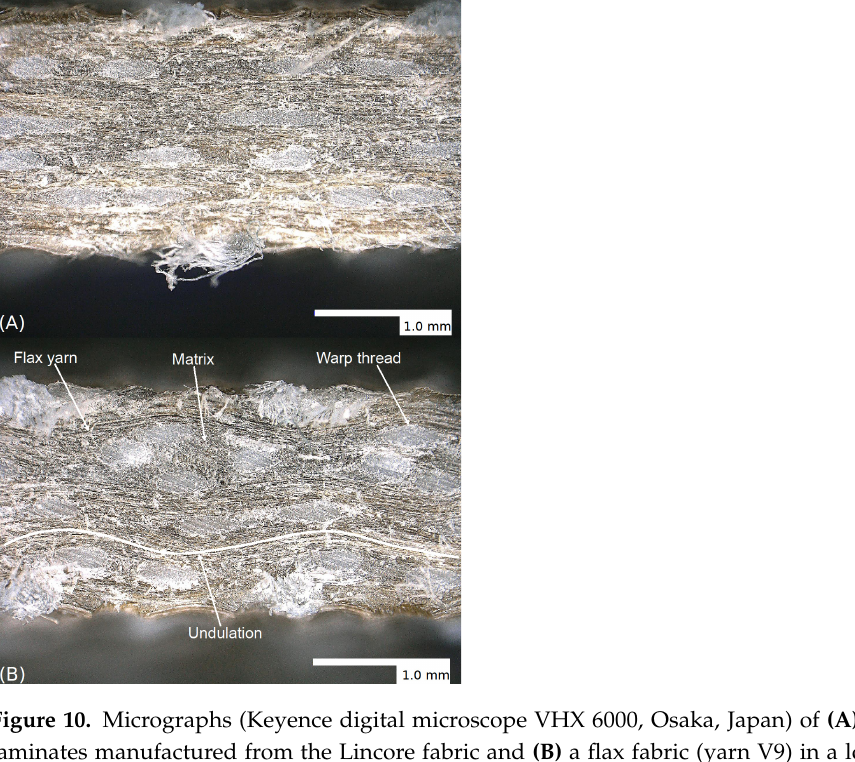
Figure 9. Tensile strength ( A ) and Young’s modulus ( B ) of composites produced by vacuum infu- sion and autoclave injection. The results are shown as mean values with the standard deviation as error bars.